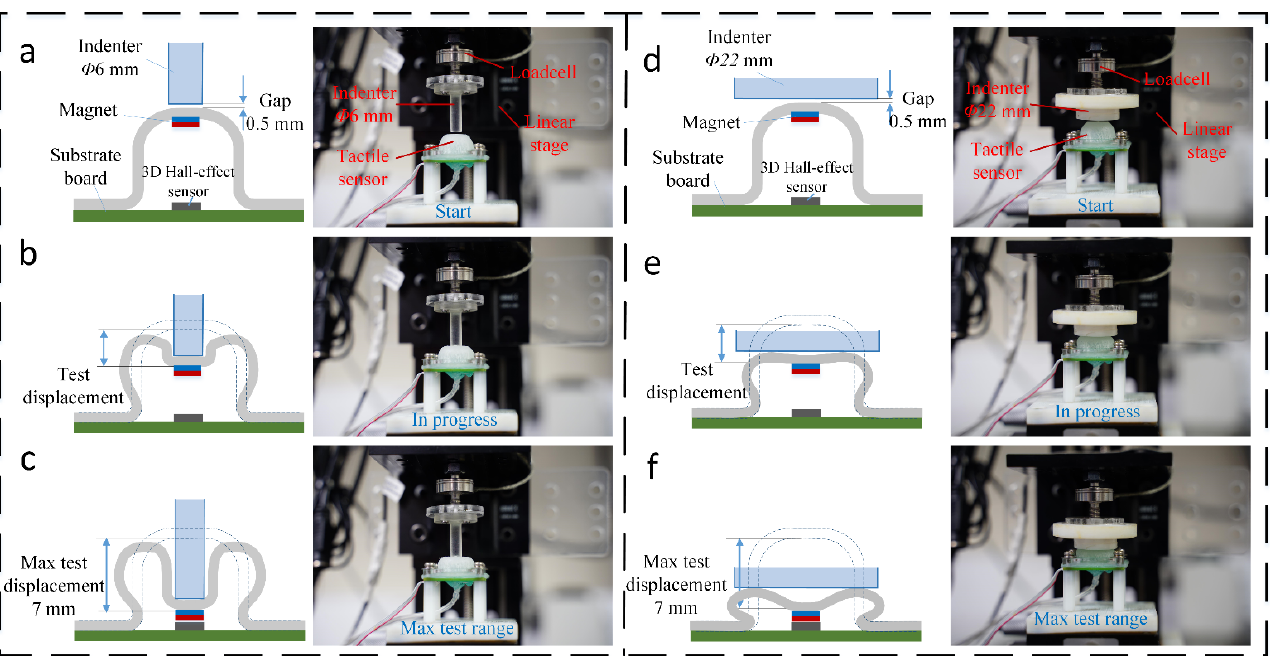
Figure 4. The experiment setup for the calibration of the proposed soft sensor: ( a ) the 6 mm diameter indenter lowered to a distance of 0.5 mm gap to the top surface of the elastomeric dome, ( b ) sensor then deformed by the compression of the indenter onto the dome, ( c ) indenter has reached the maximum range of the sensor, stopped, and immediately reversed upward to its initial start position. ( d – f ) show the same operation with a 22 mm diameter indenter.